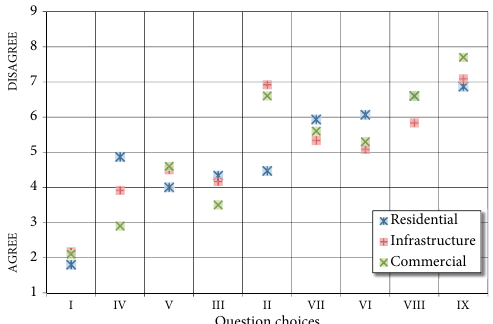
Fig. 2. Marketing perspectives of companies based on key interest